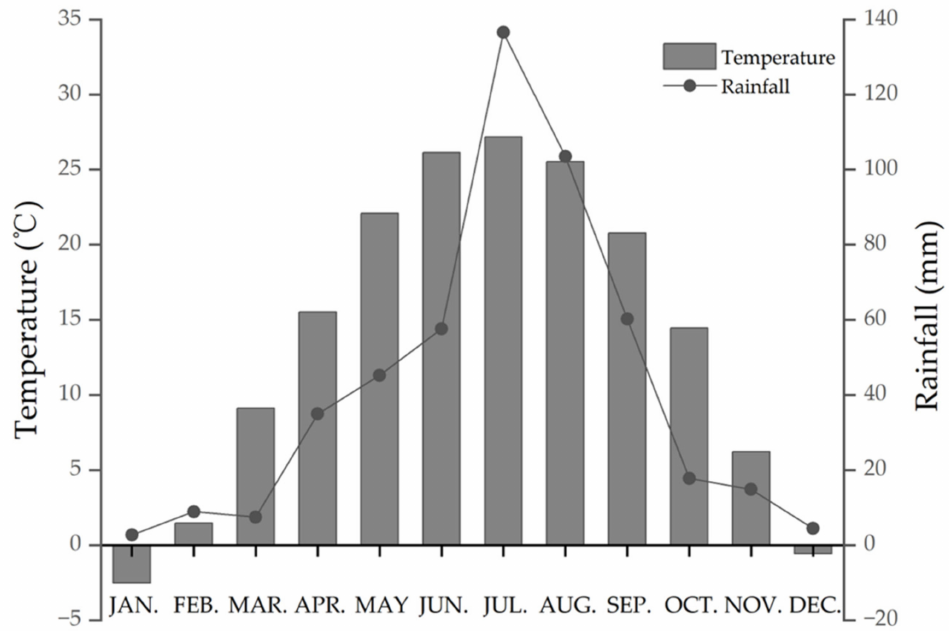
Figure 1. Average monthly temperature and precipitation in Wei County from 2007 to